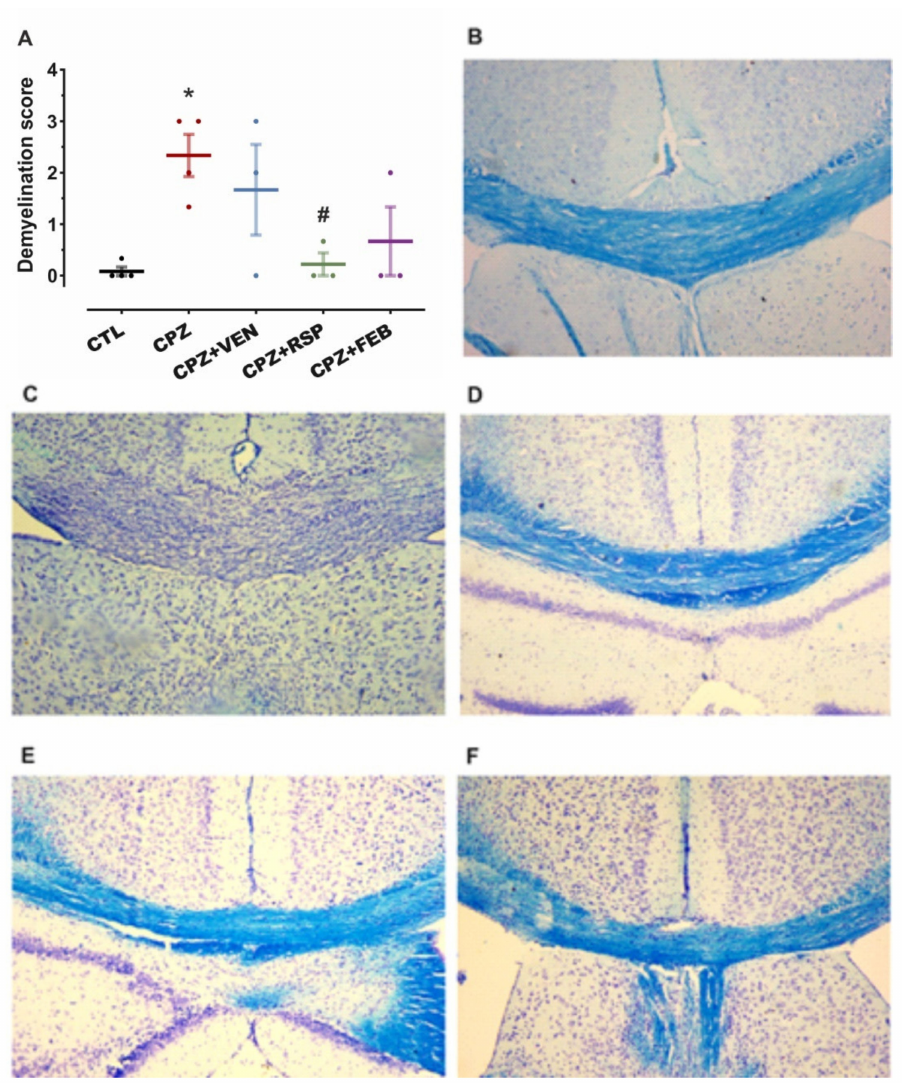
Figure 2. Myelin integrity in mice corpus callosum (CC) after 5 weeks of treatment; staining with Luxol Fast Blue (LFB) and cresyl violet (CV). ( A ) Variation in demyelination score between treated groups. ( B ) CTL, ( C ) CPZ, ( D ) CPZ + VEN, ( E ) CPZ + RSP, ( F ) CPZ + FEB. Data are presented as means ± standard error mean (S.E.M). CTL—control ( n = 4); CPZ—cuprizone 400 mg · kg − 1 ( n = 4); CPZ + VEN—cuprizone 400 mg · kg − 1 and venlafaxine 60 mg · kg − 1 ( n = 3); CPZ + RSP—cuprizone 400 mg · kg − 1 and risperidone 2 mg · kg − 1 ( n = 3); CPZ + FEB—cuprizone 400 mg · kg − 1 and febuxostat 5 mg · kg − 1 ( n = 3). * p < 0.05 vs. CTL; # p < 0.05 vs.